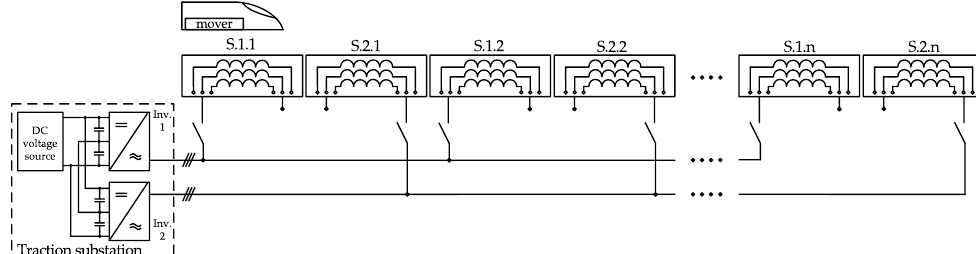
Figure 11. Two three-level inverters in interleaved operation allow continuous generation of the thrust force. The functional block diagram showing the main components of the system is presented in Figure 12. The Automatic Pod Control (APC) unit defines the desired movement parameters like maximum acceleration, velocity or stop position and sends this information to the Inverter Control Board (IBC). In order to achieve the desired acceleration and speed, the stator current in appropriate segments is controlled by the ICB based on the Field Oriented Control algorithm using the information about the position of the vehicle on the track.